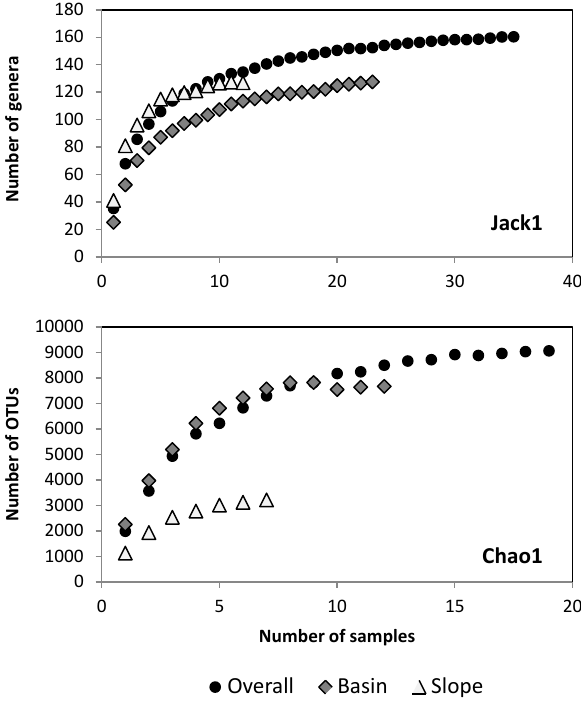
Fig. 6. Richness estimators Jack1 and Chao1 for nematode genera and microbial OTUs, respectively. The overall line indicates esti- mates for the whole data